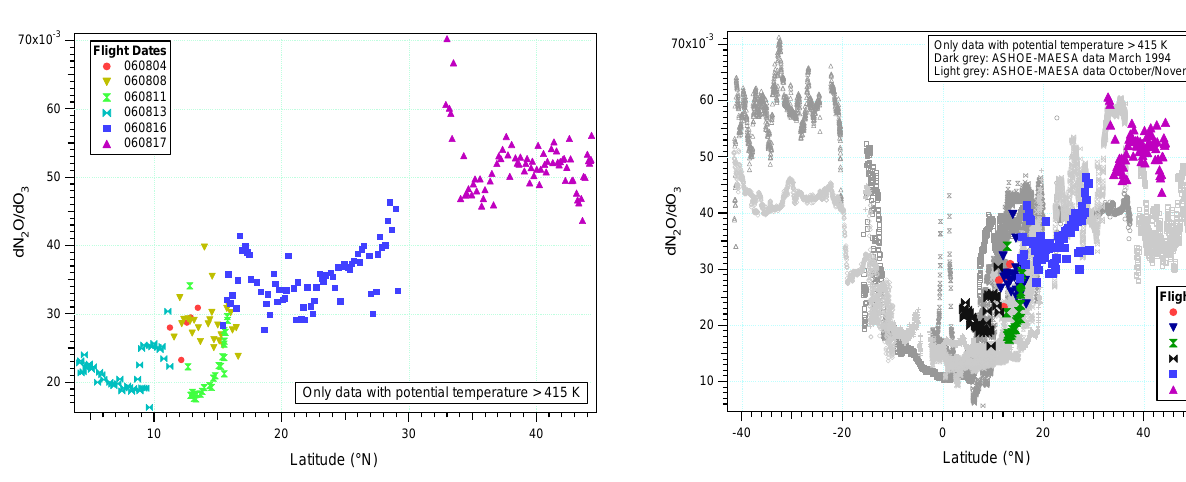
Fig. 12. Slope dN 2 O/dO 3 against latitude for the AMMA/SCOUT- O3 (coloured) and ASHOE/MAESA (grey)